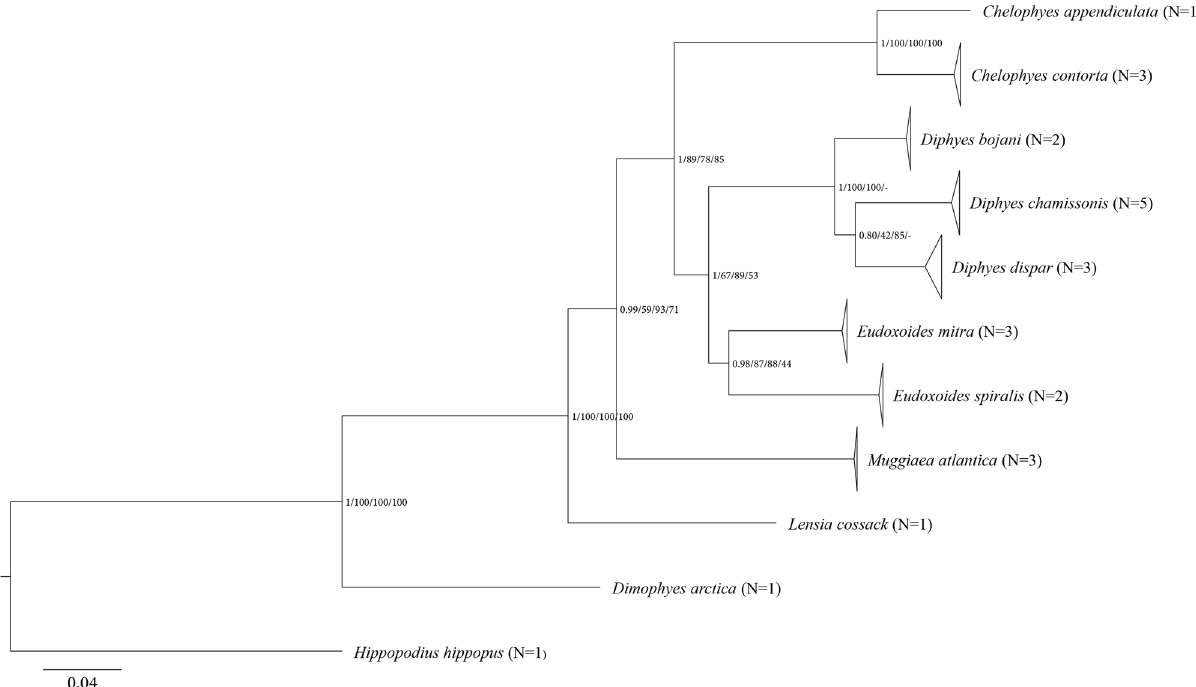
Figure 6. Molecular phylogenetic tree of Diphyidae species based on 25 concatenated sequences. All positions containing gaps and missing data were eliminated. The number of each node dictates the BI/NJ/ML/MP bootstrap values. ’N’ indicates the number of each sequence obtained in this